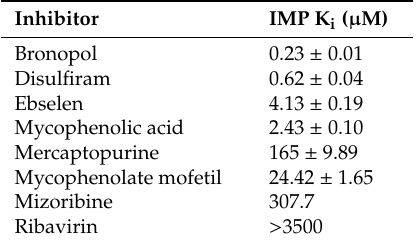
Table 3. Inhibition of C Las IMPDH Δ 98 ‐ 201 by eight inhibitors.